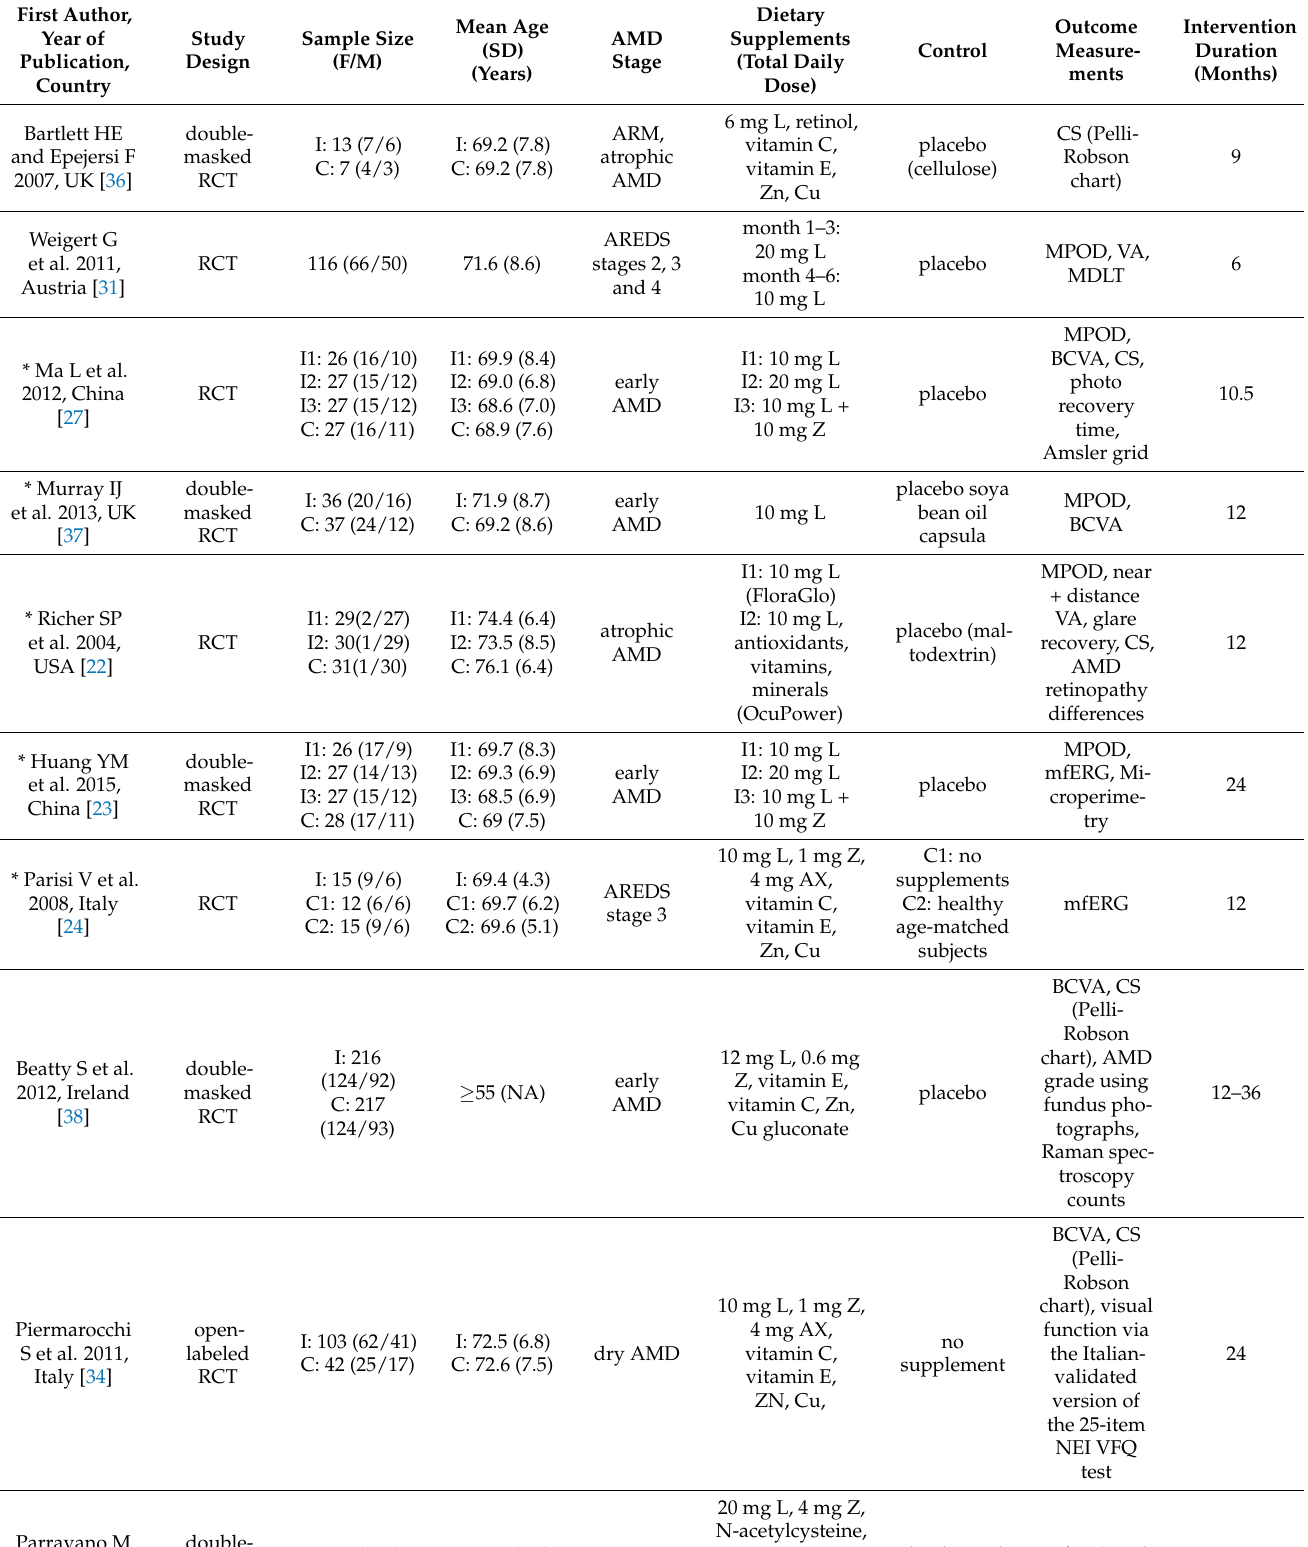
Table 1. Publications selected for the systematic review, including study